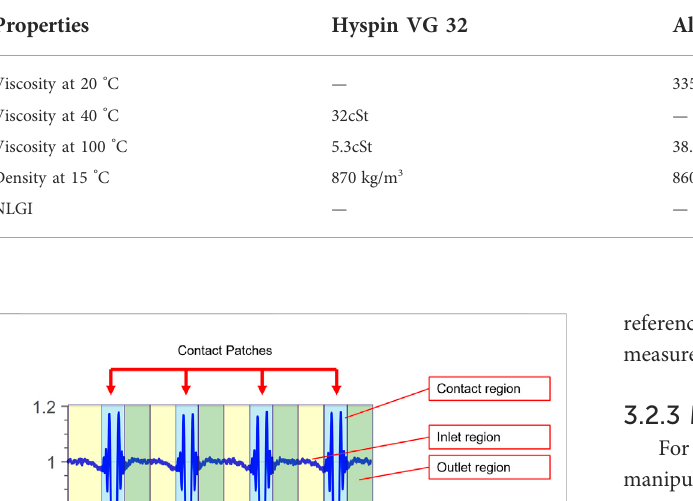
TABLE 1 Manufacturer stated properties of lubricating oils used for bearing test.